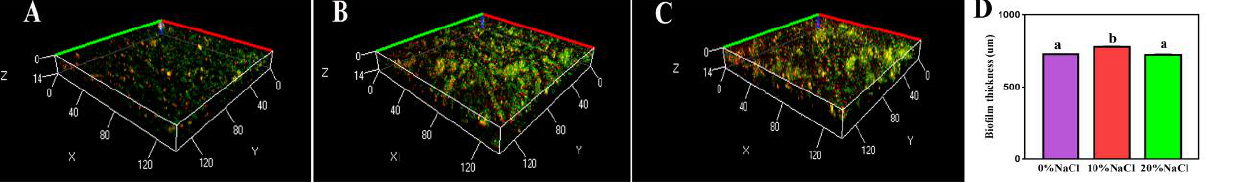
Figure 2 . CLSM images of treated S. aureus biofilm cells. ( A ) Control group; ( B ) 10% NaCl group; ( C ) 20% NaCl group; ( D ) thickness of biofilm.